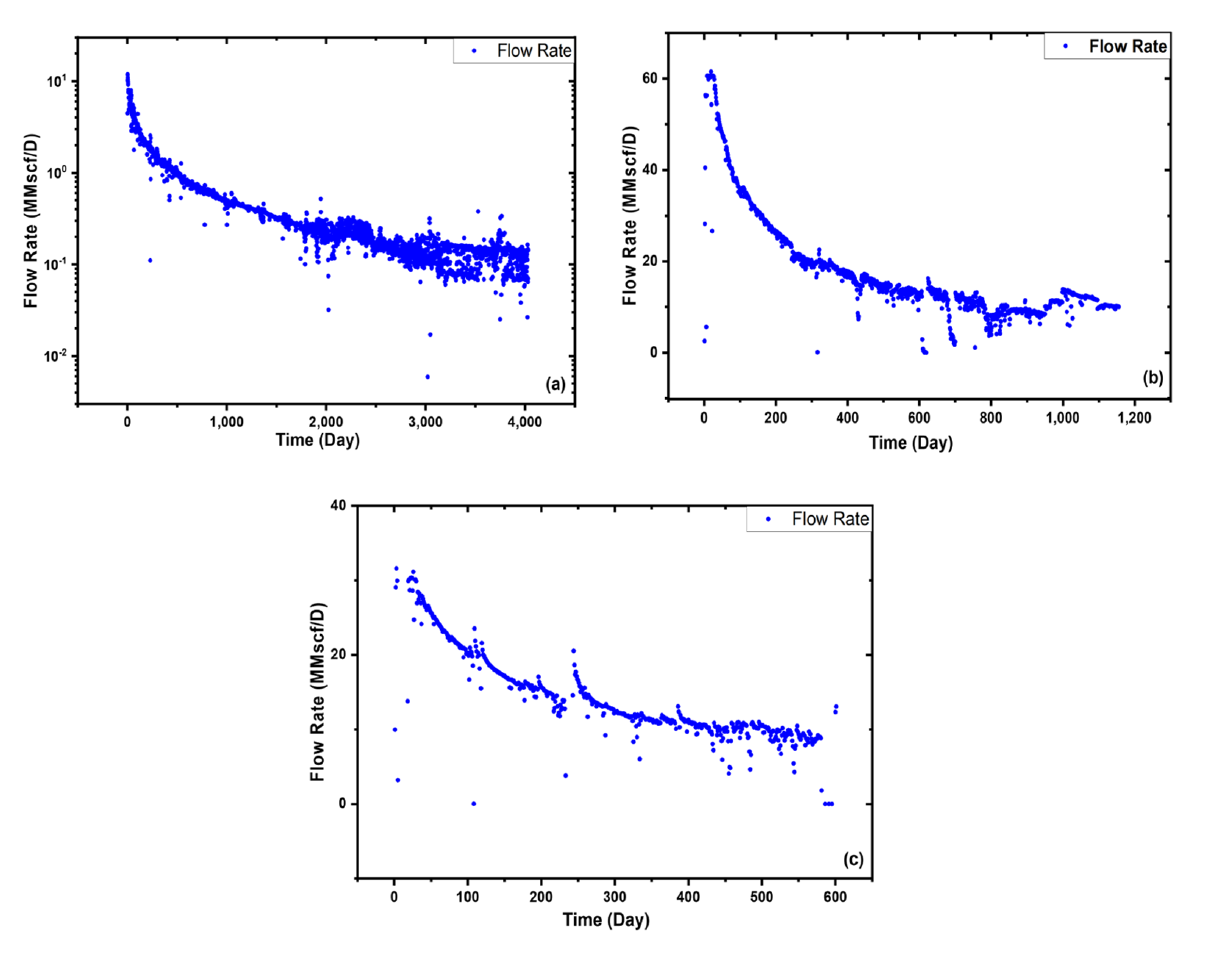
Figure 14. The actual flow rate of ( a ) well_12, ( b ) well_29, ( c ) well_40.